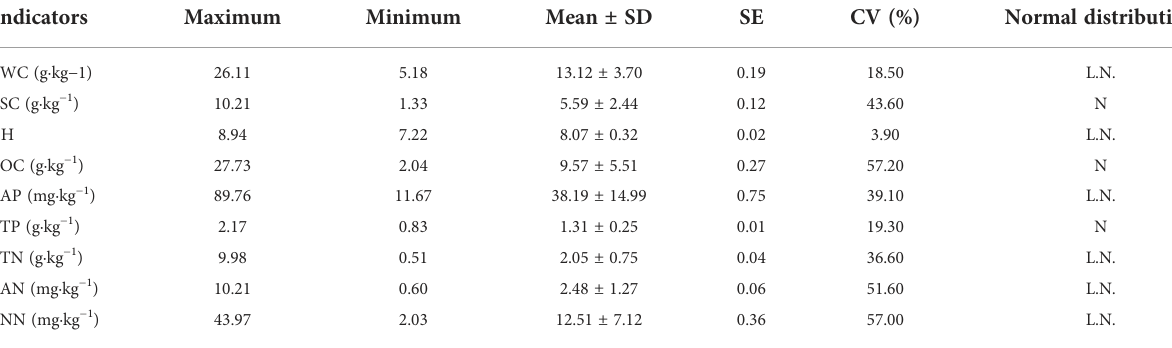
TABLE 2 Descriptive statistics of soil